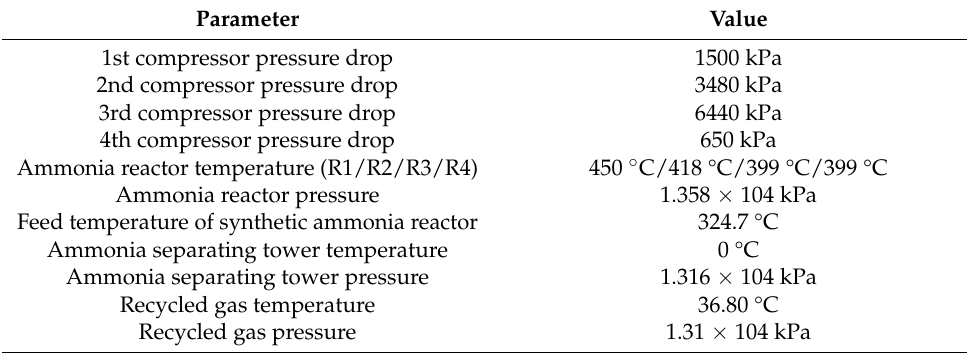
Table 3. Key model